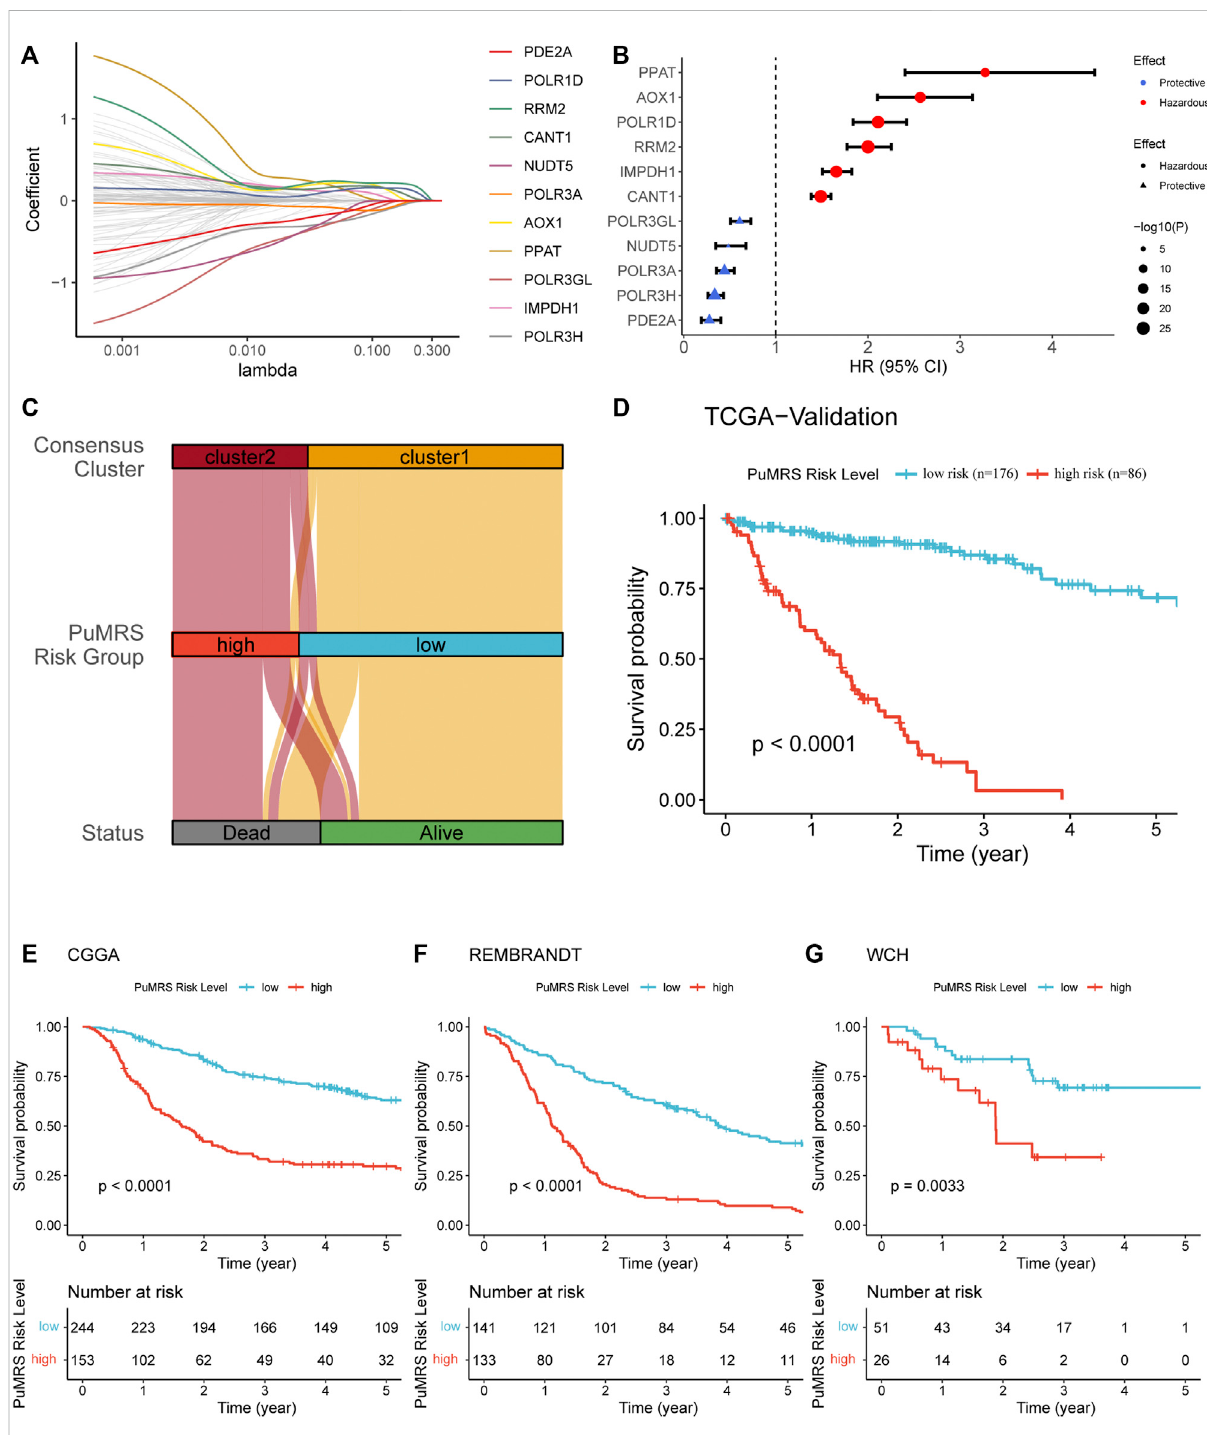
FIGURE 5 ExpressionsignatureofPuMGsanditsrelationshipwithprognosis. (A) Averageofcoef fi cientsof11criticalPuMGsintheLASSOCoxregressionat each lambda value. (B) The effect of every critical PuMG on the prognosis of glioma. (C) The relationship between the consensus clusters and two CRGRS risk groups. (D) K-M curve of the TCGA validation set, cut off = − 1.566. (E) K-M curve of the CGGA cohort, cut off = − 3.433. (F) K-M curve of the REMBRANDT cohort, cut off = 1.128. (G) K-M curve of the WCH cohort, cut off = −